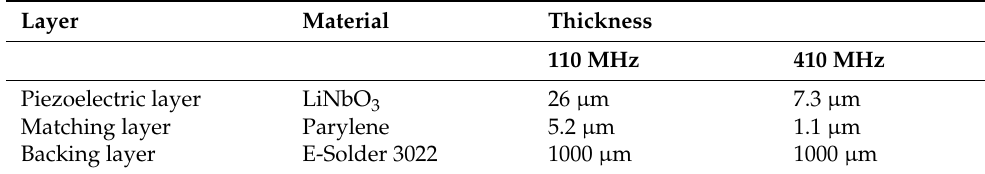
Table 1. Design parameters for UHF single-element transducers. Layer